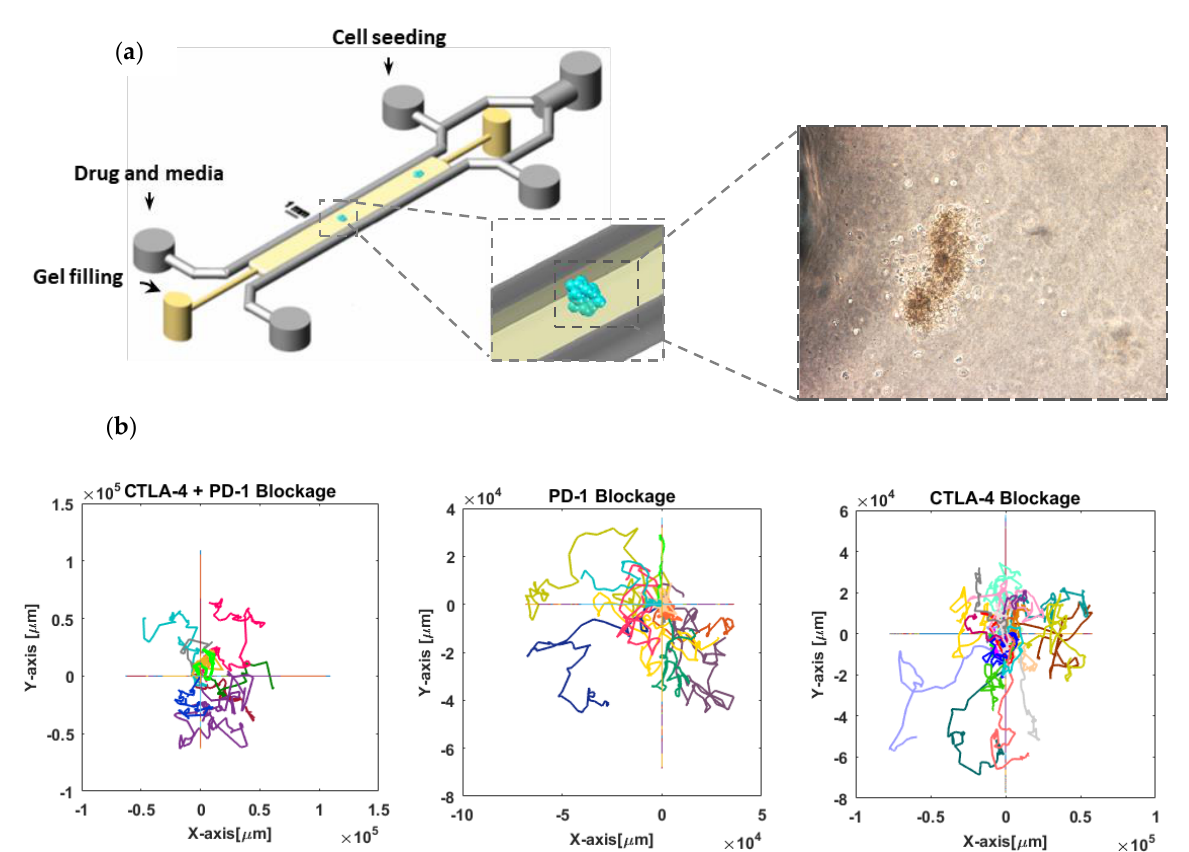
Figure 1. Tracking lymphocyte migration in 3D organotypic tumor culture. ( a ) Schematic view of the microfluidic device used for 3D culture of thyroid tumor spheroids (scale bar shows 1 mm). Patient-derived tumor spheroids containing autologous immune cells were loaded in a collagen medium in the central channel of the device and subjected to anti-PD-1 or anti-CTLA-4 antibody treatment. A representative bright-field image of a thyroid tumor spheroid shows cells migrated into the surrounding collagen. ( b ) Cell trajectories in three different conditions of pathway inhibition. A total of 12, 28, and 9 migrating cells were tracked in the conditions of anti-PD-1, anti-CTLA-4, and combination exposure, as indicated. For each experiment, individual trajectories are shown with distinct colors, and all trajectories started from the same point (coordinate center) that is overlaid on the same graph. Time-lapse images were captured every 15 min for at least 130 h.